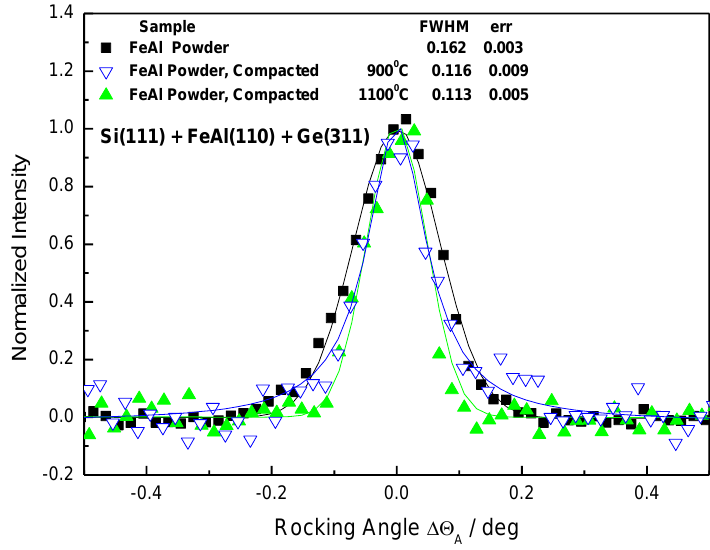
Figure 12. Analyzer rocking curves for the SPS compacted Fe28Al from the initial powder sintered at 900 °C, 1000 °C, and 1100 °C.